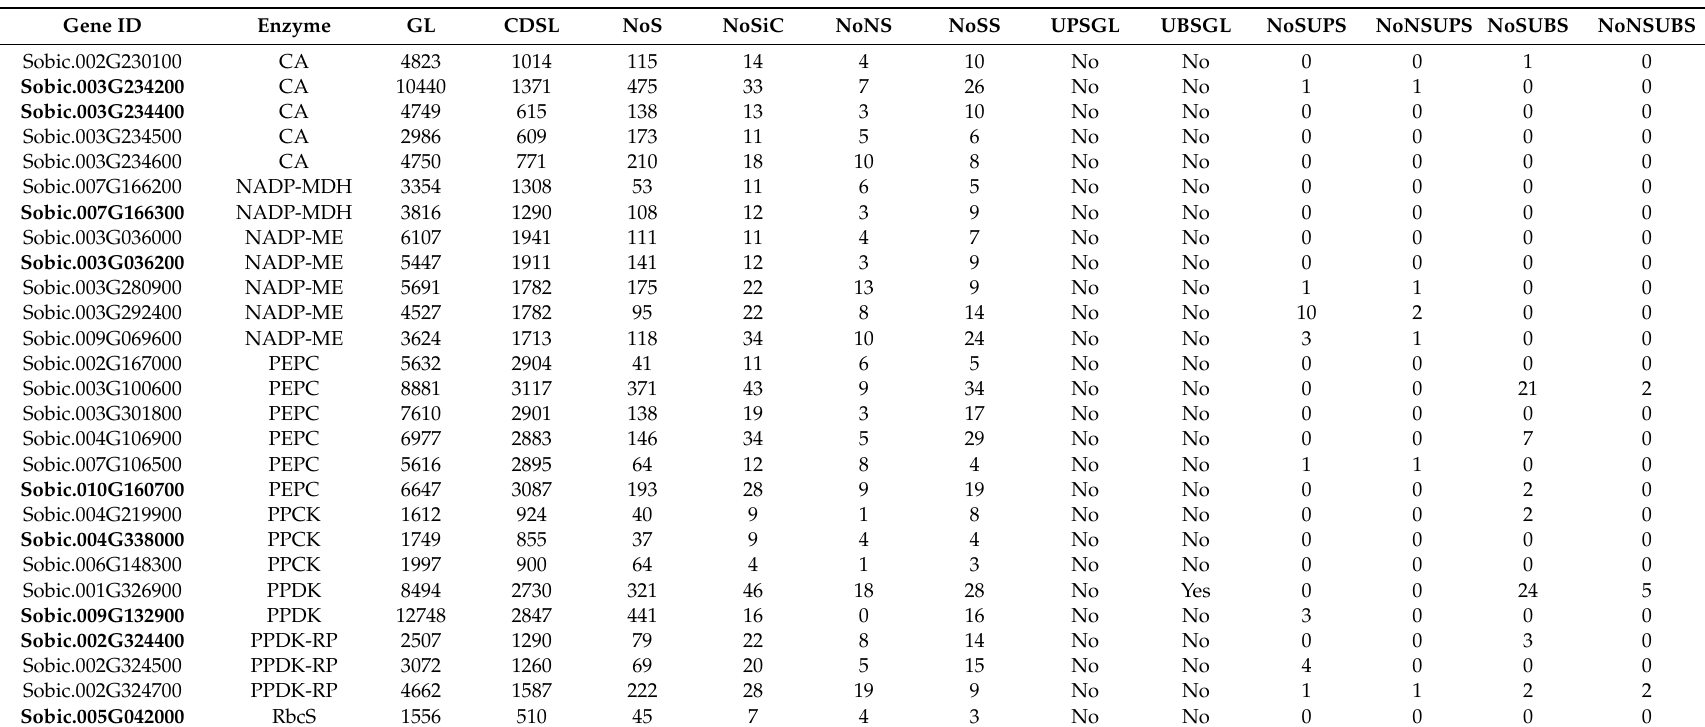
Table 1. Single nucleotide polymorphism (SNP) information and selection signals across 27 genes from C 4 gene